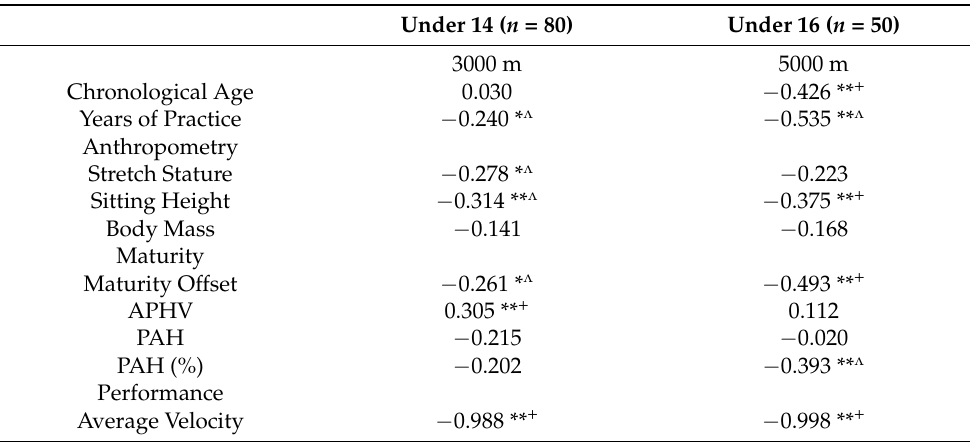
Table 4. Correlations between chronological age, years of practice, anthropometry, and maturity parameters with performance in U14 and U16 kayaker groups ( r and r s